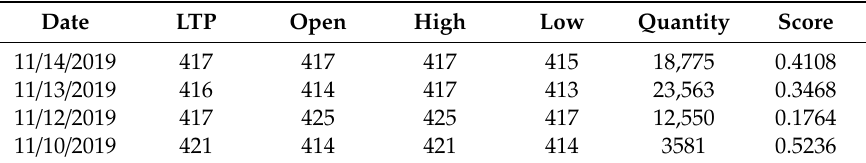
Table 2. Samples of combined datasets.